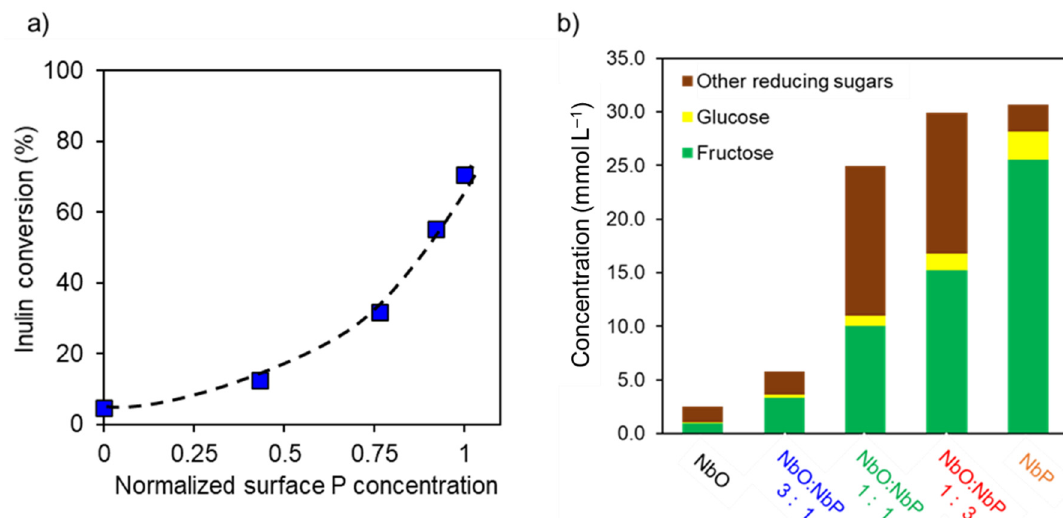
Figure 5. Results of the batch catalytic reaction of inulin hydrolysis in water on NbO, NbP, and relevant NbO:NbP mix- tures as a function of reaction temperature (from 50 to 90 °C with linear increase of 0.12 °C min − 1 ), expressed as residual inulin bond concentration ( a ); and reducing sugar concentration ( b ).